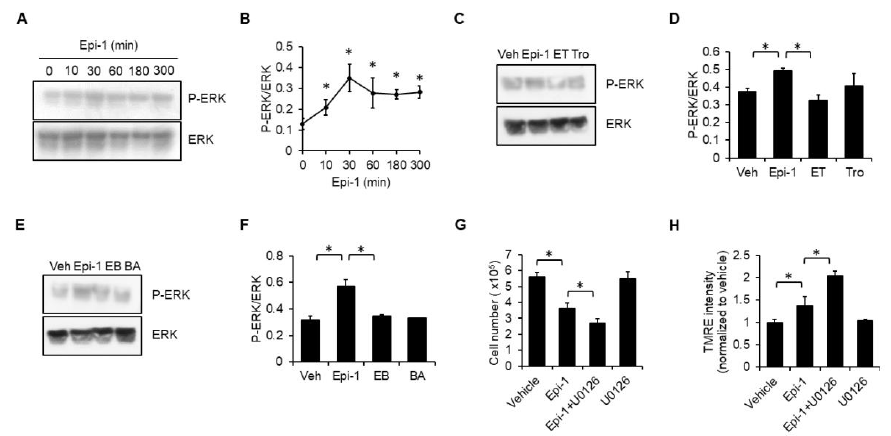
Figure 6. Activation of extracellular signal-regulated kinase (ERK) signaling plays a protective role in epi-1-induced cytotoxicity. ( A ) Cells were treated with epi-1 for different times, as indicated. Whole cell lysates were collected and immunoblotted with anti-phospho-ERK and anti-ERK antibodies. ( B ) Band intensities were measured with ImageJ. ( C ) Cells were preincubated with Trolox (Tro; 100 μM) for 1 h, followed by epi-1 for an additional 0.5 h. ERK activation was determined as described in (A). Veh: vehicle; ET: epi-1+Trolox; Tro: Trolox. ( D ) Band intensity was measured with ImageJ. ( E ) Cells were